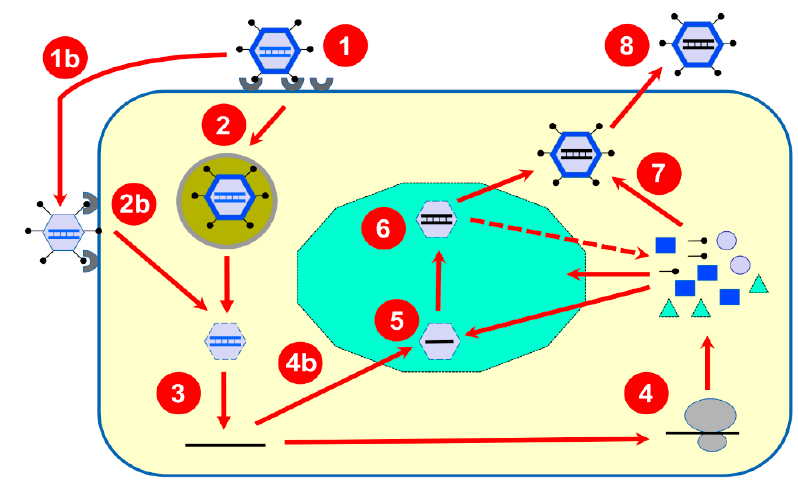
Figure 1. Summary of the reovirus multiplication cycle. Upon binding to different host-cell receptors ( 1 ), the reovirus virion containing the double-stranded RNA genome (in blue) is internalized by endocytosis ( 2 ) and transported towards late endosomes ( 2 ); they are then partially disassembled to produce transcriptionally active cores that are released in the host-cell cytoplasm ( 3 ). Alternatively, due to the action of extracellular proteases, partially uncoated virions known as infectious subviral particles (ISVPs) are generated ( 1b ) and can bypass endocytosis and penetrate the host-cell membrane ( 2b ) also leading to transcriptionally active cores in the cytoplasm ( 3 ). These “parental” cores possess all required enzymatic activities to synthesize and release multiple copies of capped messenger RNA (in black) synthesized from the ten viral double-stranded RNA genome segments as a template. Released mRNAs are translated by the cellular machinery ( 4 ) to generate both structural and nonstructural proteins; alternatively, some copies ( 4b ) will be recruited to viral inclusions (in green) made by viral proteins. One copy of each 10 viral mRNAs will be packaged by viral inner capsid proteins to form intermediate structures ( 5 ) where synthesis of the second strand will take place to generate newly formed double-stranded RNA genomes retained in “progeny” particles ( 6 ). These, more abundant particles, in turn, are believed to be responsible for the synthesis of the bulk part of viral mRNA responsible for viral proteins synthesis (as indicated by the dotted arrow). Outer capsid proteins will be added ( 7 ) to finalize viral particles assembly before release of fully assembled virions ( 8 ).